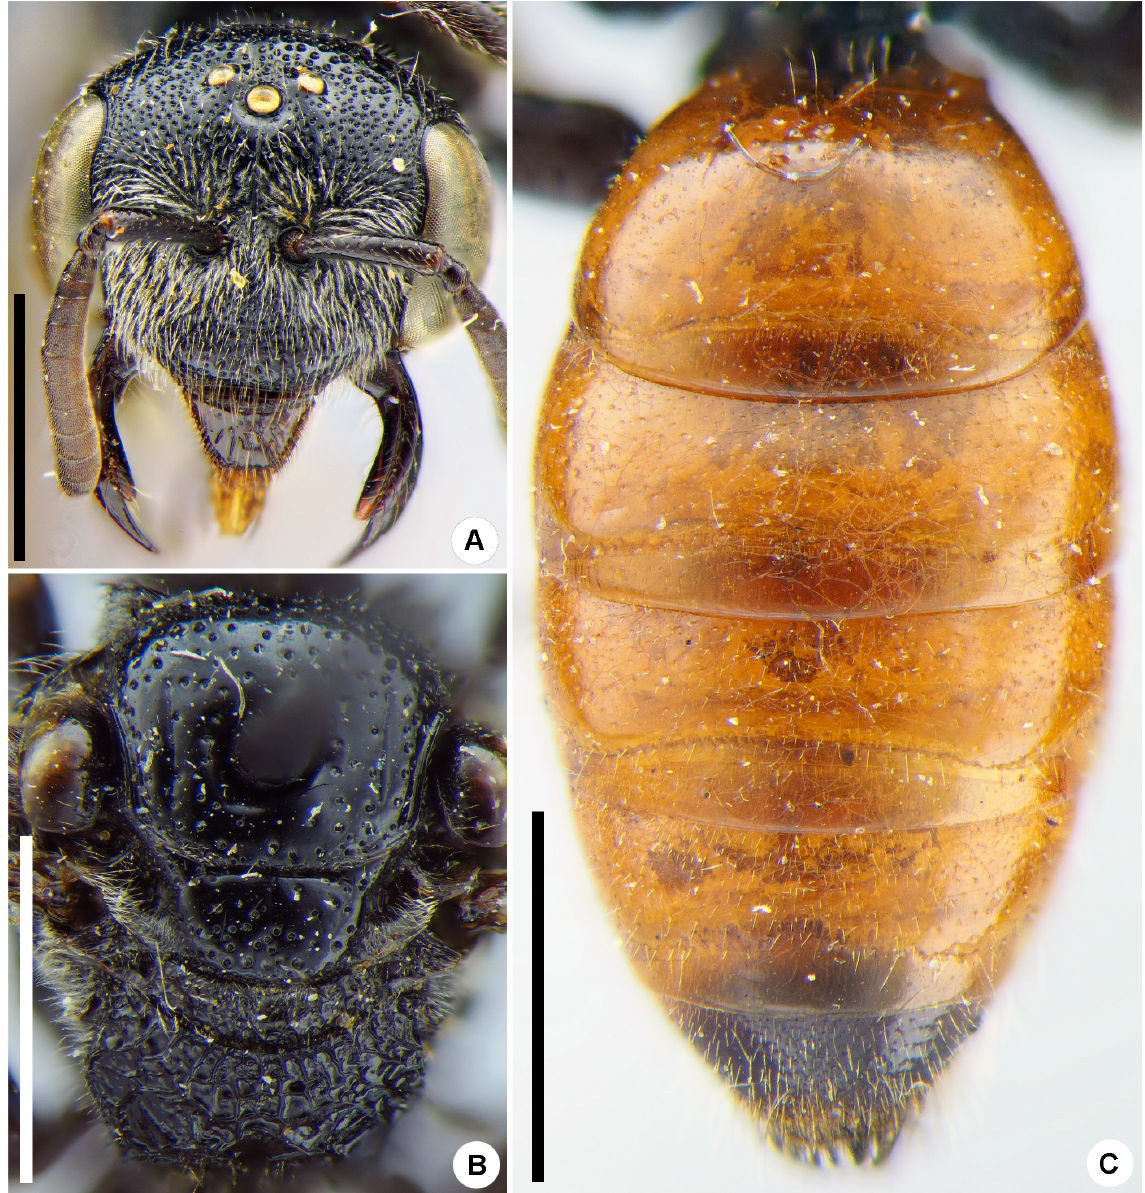
Fig. 13. Sphecodes lasimensis Blüthgen, 1927, ♀ (PCMS). A . Head in frontal view. B . Mesosoma in dorsal view. C . Metasoma in dorsal view. Scale bars = 1.0